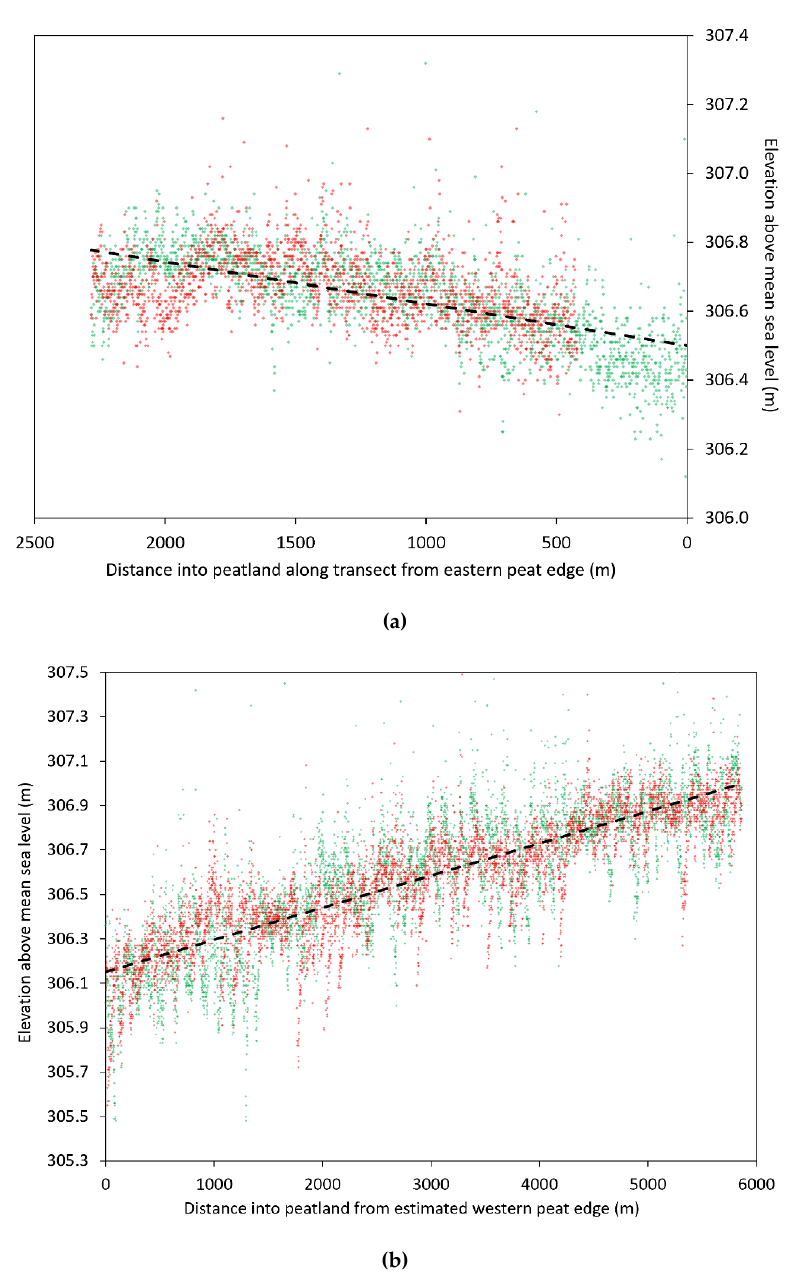
Figure 4. Estimated ground elevation points per meter along UAV transect from the estimated peat edge. Green points are derived from the outgoing flight and red from the returning flight. ( a ). Ekolongouma. The total transect is 2269 m long, for 1862 m of which we have both outgoing and returning flight data. The fitted line slope is 0.121 m.km –1 . ( b ). Epena. Total transect length is 5861 m. The fitted line slope is 0.145 m.km –1 .